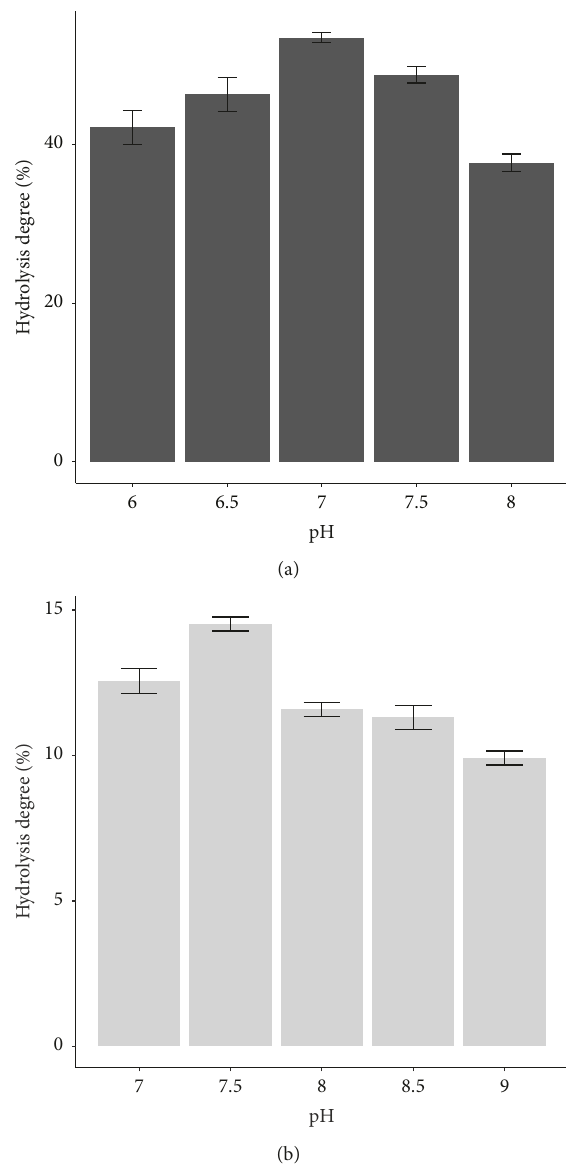
Figure 3: Effect of pH on hydrolysis degree of (a) CRL and (b)